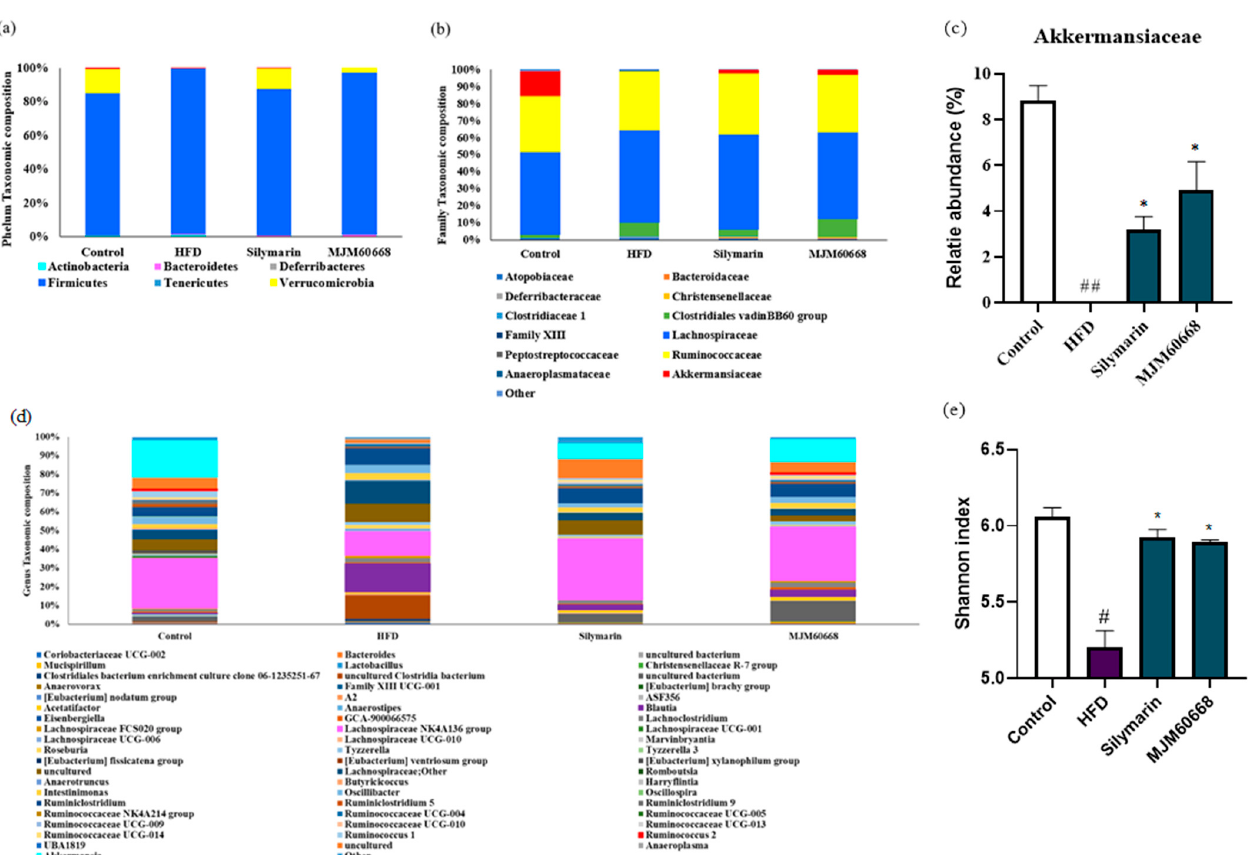
Figure 9. LAB supplementations modulate the composition of gut microbiota. ( a ) taxonomic composition at the phylum level. ( b ) Taxonomic composition at the family level ( c ) relative abundance of Akkermansiaceae. ( d ) taxonomic composition at the genus level. ( e ) Alpha-diversity is indicated by the Shannon index. # p < 0.05, ## p < 0.01 compared with control group, * p < 0.05 compared with HFD group.